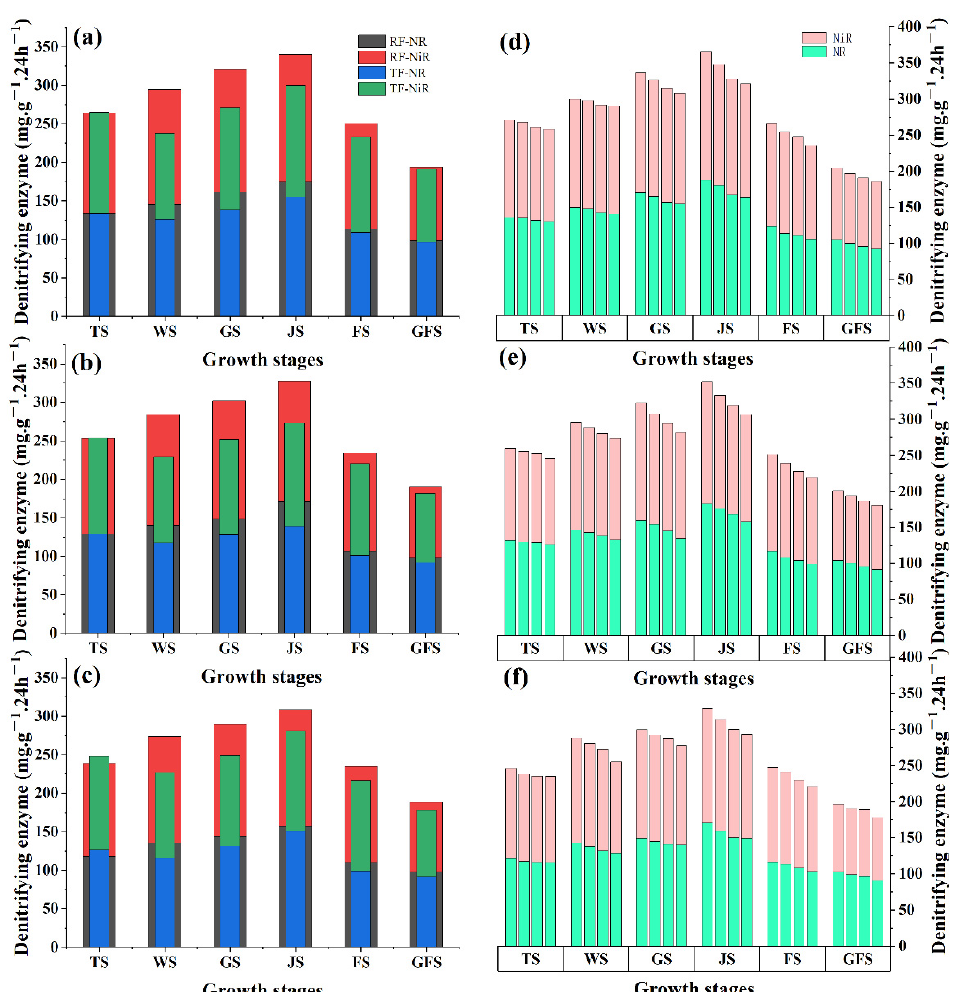
Figure 4. Effects of planting models and limited irrigation on denitrifying enzymes under simulated rainfall conditions during the winter wheat growing seasons. ( a , d ) represent Note: P1: 275 mm rainfall; ( b , e ) represent P2: 200 mm rainfall; ( c , f ) represent P3: 125 mm rainfall. TF: traditional flat planting; RF: ridge–furrow mulching system. Four different irrigation amounts, 150 mm, 75 mm, 37.5 mm, and 0 mm were used. TS: tillering stage; RWS: re-wintering stage; GS: green stage: JS: jointing stage; FS: flowering stage; GFS: grain filling stage.